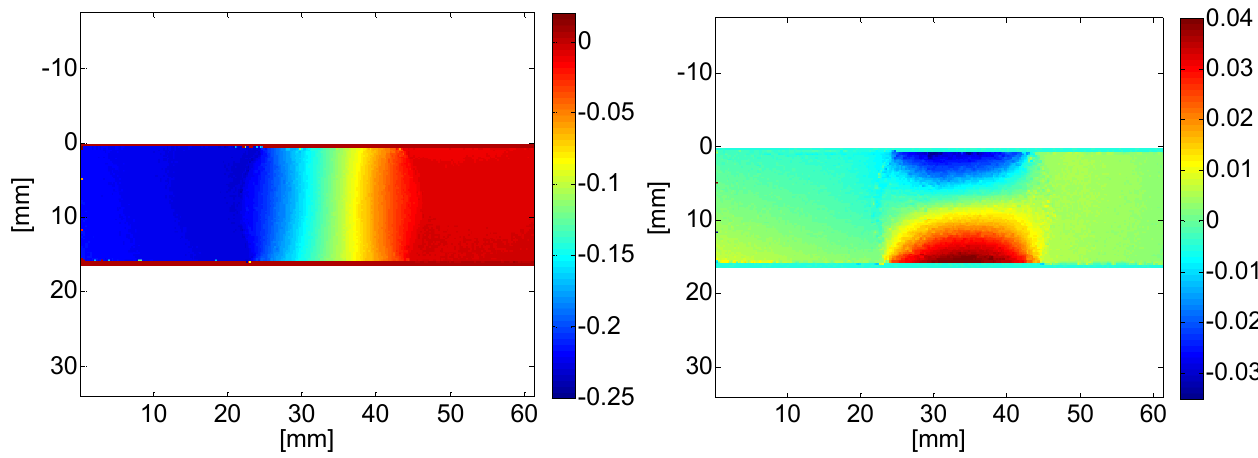
Figure 5: The displacement field in the heterogeneous specimen under tensile test (loaded specimen head on the left, fixed on the right), reconstructed by the correlation of the digital image 7 (the reference one) and 16 acquired during the test (see Fig.